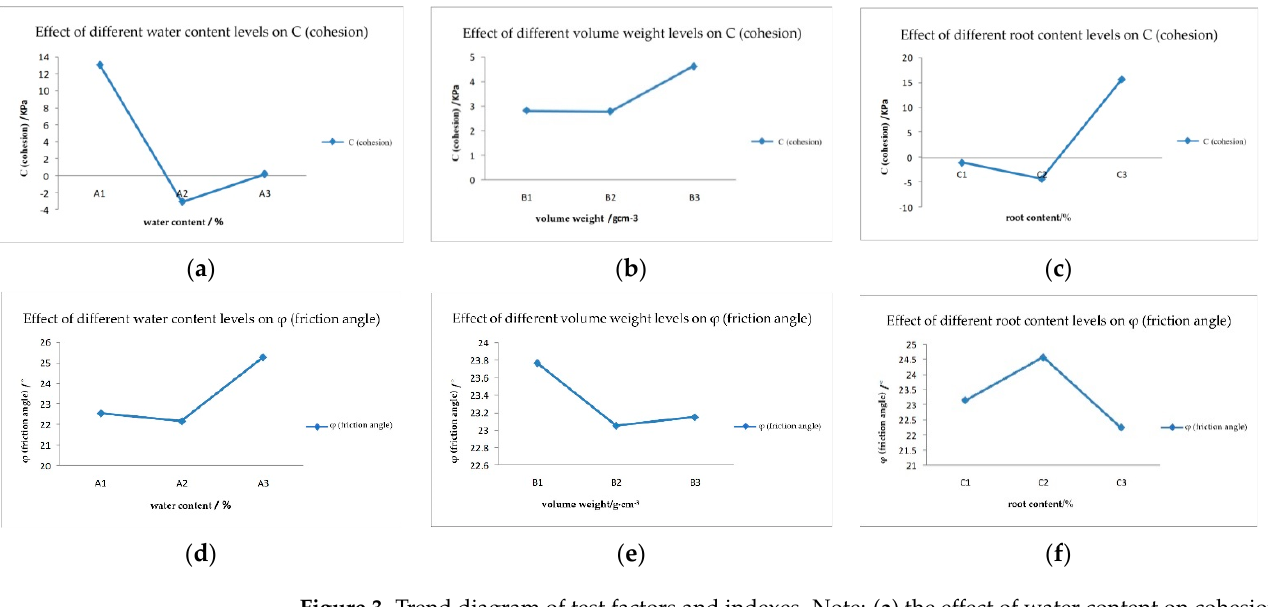
Table 6. Variance analysis of shear srength of root–soil composites.